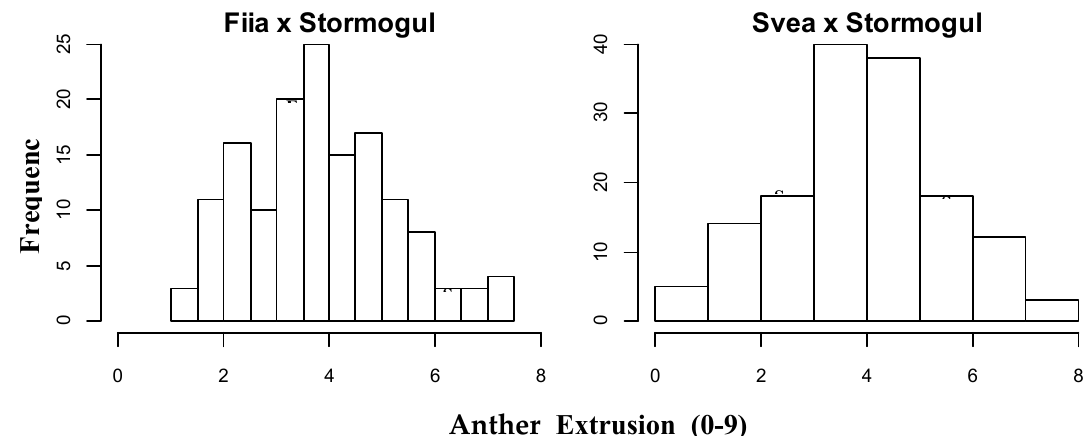
Figure 3. Distribution of BLUP values for days to flowering in the Fiia by Stormogul ( Left ) and Svea by Stormogul ( Right ) recombinant inbred line populations (data averaged for 2012 and 2013).